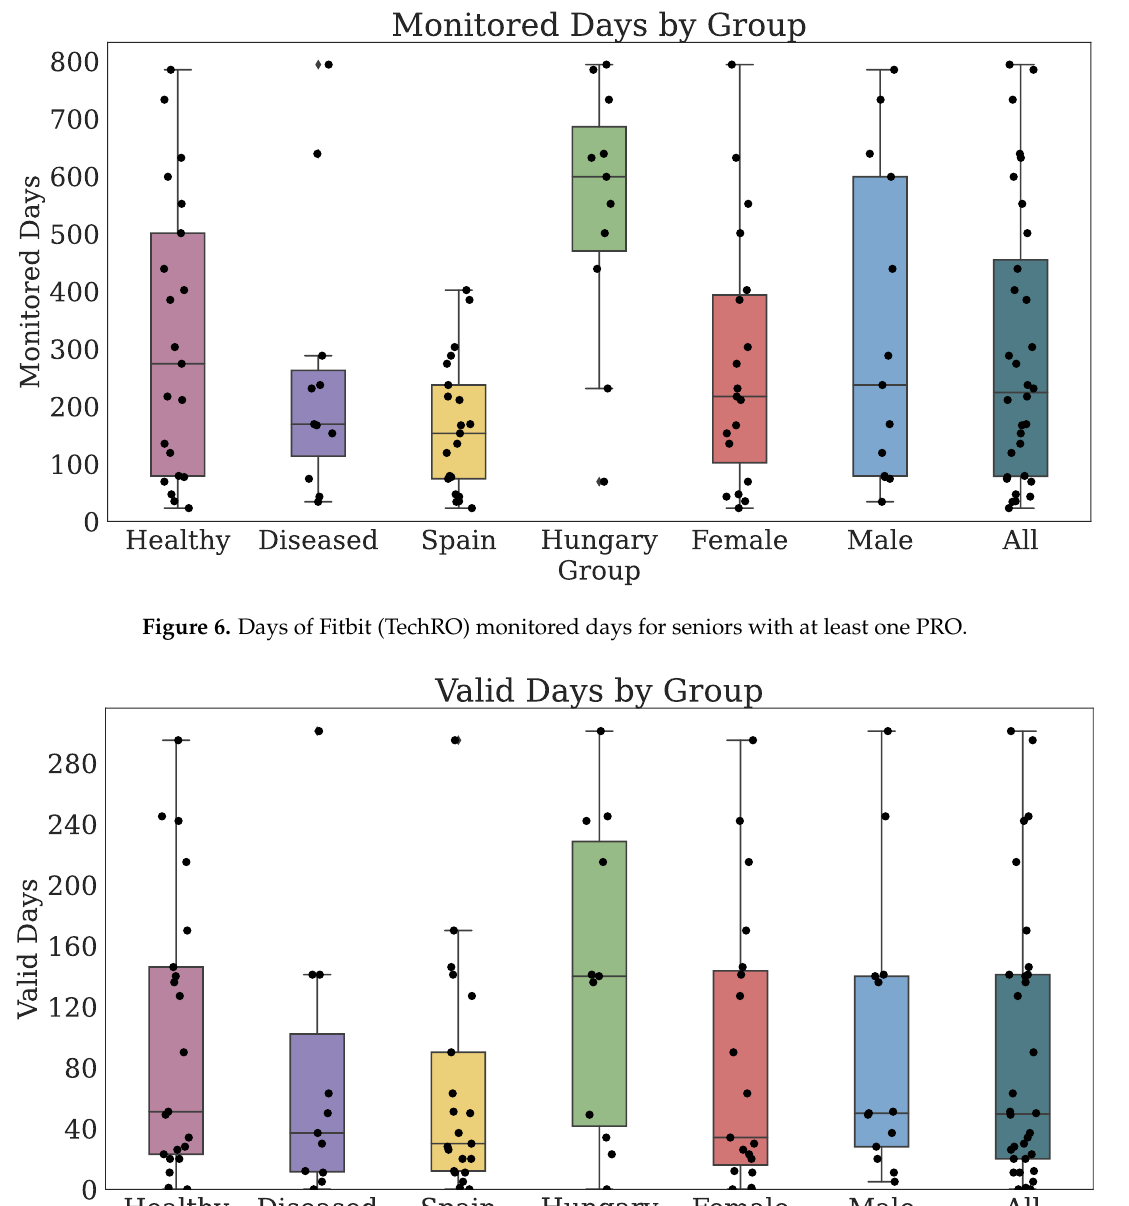
Figure 6. Days of Fitbit (TechRO) monitored days for seniors with at least one PRO